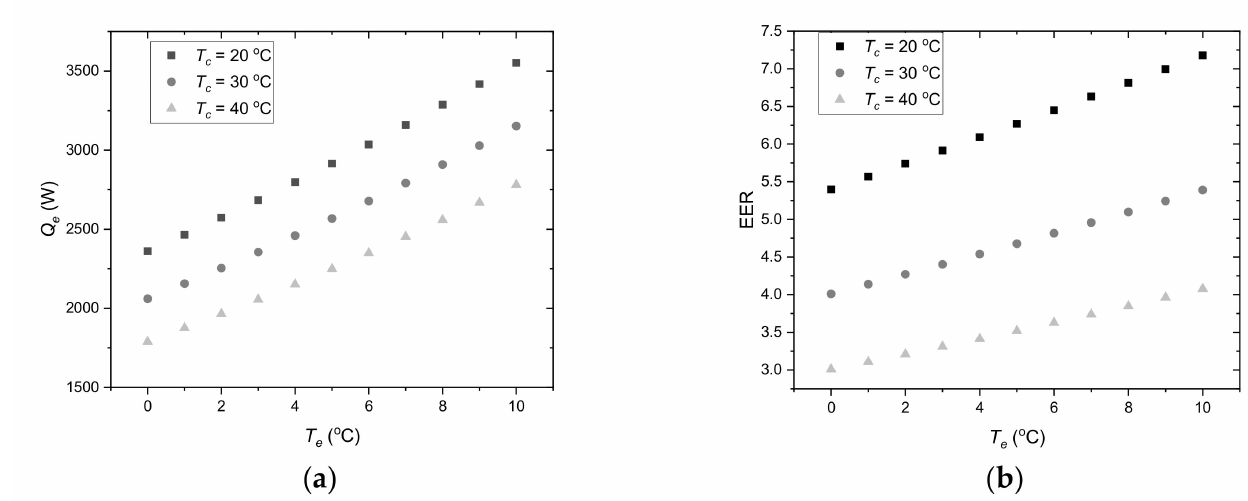
Figure 6. Compressor chiller load ( a ) and energy efficiency ratio ( b ) as a function of the evaporating temperature T e